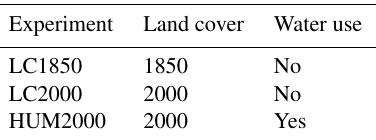
Table 1. Overview of experiments. Water use includes water for domestic, industrial and livestock use, irrigation, dams and reser- voirs as well as desalinized water used in coastal areas (Wada et al.,